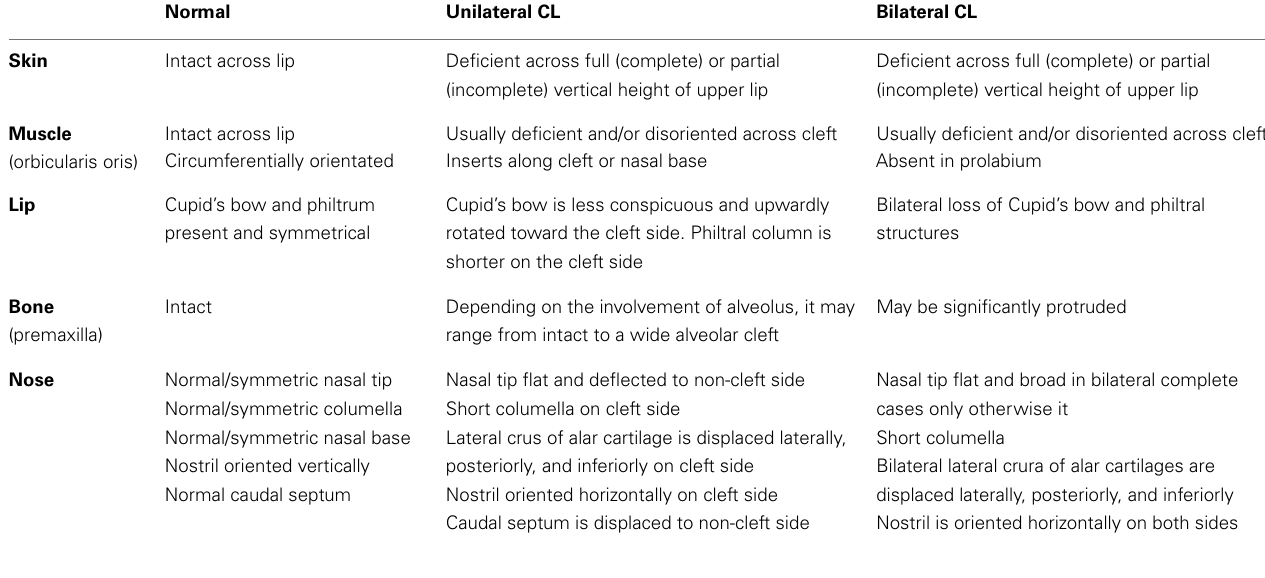
Table 1 |Anatomy of the cleft